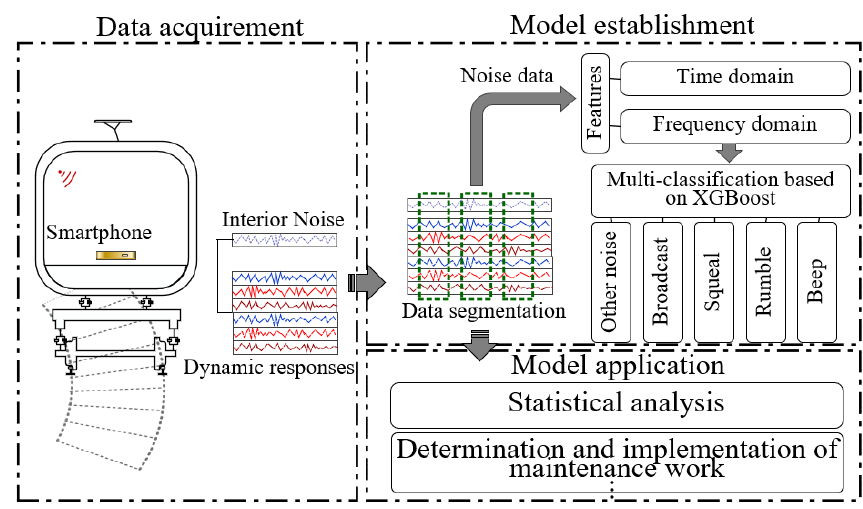
Figure 1. Research methodology of this study.